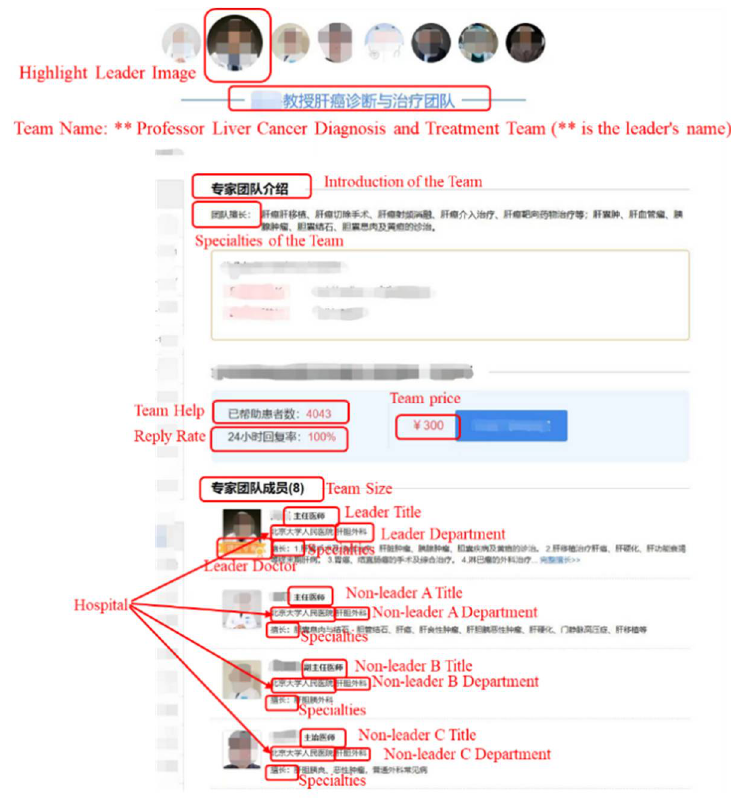
Figure 2. Homepage of online doctor team .